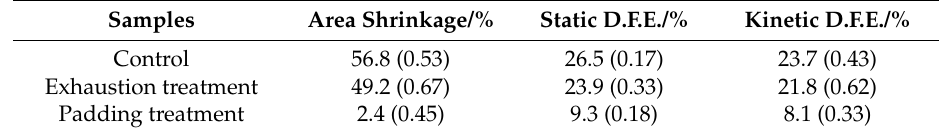
Table 1. Wool shrinkproofing properties and directional friction effect (D.F.E.).